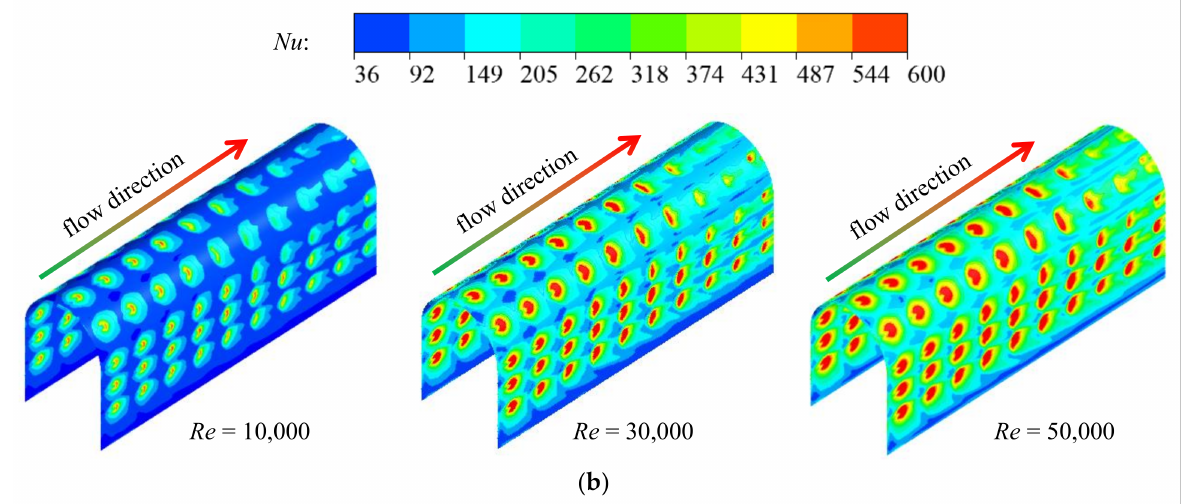
Figure 7. Distributions of flow field and heat transfer at different Re under steam cooling: ( a ) flow field distributions; ( b ) heat transfer